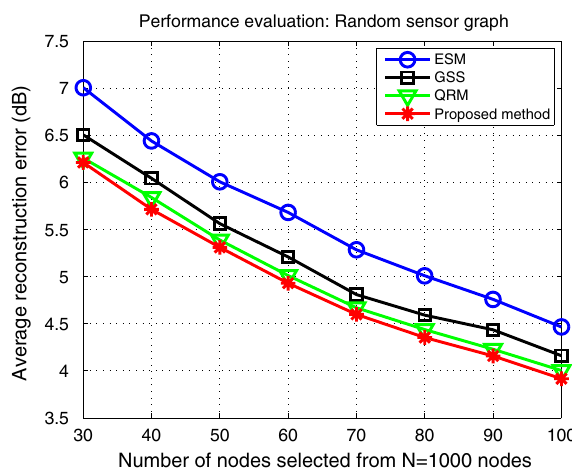
Fig. 2 Performance evaluation for noisy non‑bandlimited graph signals on RSG with σ = 0.1 by varying the sample size, | S |